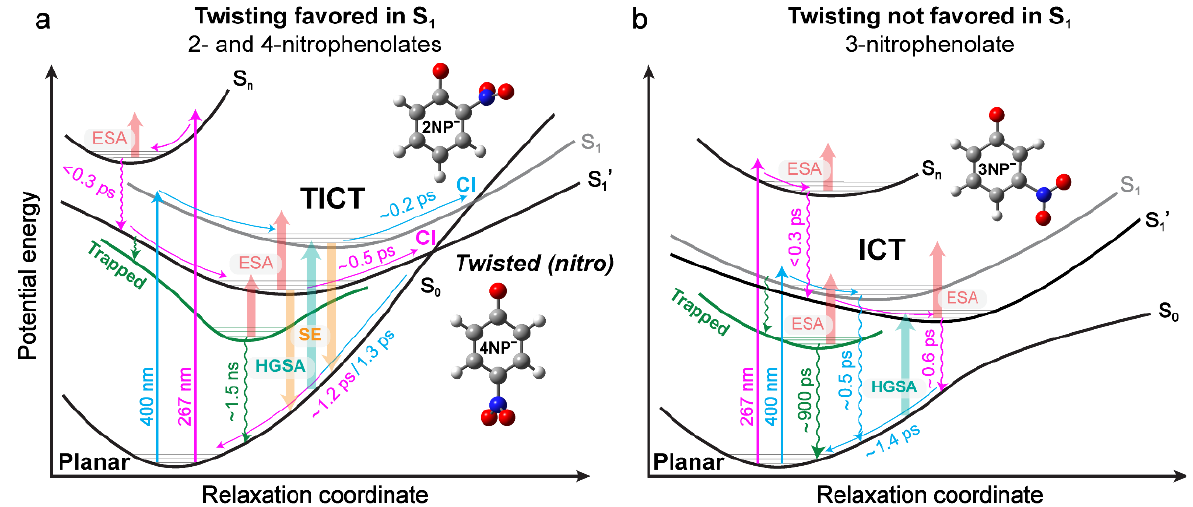
Figure 5. Schematics of the excited-state relaxation mechanisms of nitrophenolates in water. For ( a ) 2NP − and 4NP − , nitro-group twisting enables a TICT state that leads to a sloped S 1 /S 0 CI, whereas for ( b ) 3NP − , it does not twist much, and hence, accesses only an intramolecular charge transfer (ICT) state with no CI. Time constants for the pertinent processes are generally retrieved from global analysis of fs-TA spectra. The energy and relaxation coordinates are not scaled, while the colors for various processes roughly correspond to their associated wavelengths. The S 1 state is reached via 400 nm excitation, which is different from the S 1 ′ state reached via 267 nm excitation after the initial relaxation from S n . Representative ESA, SE, and HGSA features visible in the fs-TA data are indi- cated by “broad” maroon, orange, and green arrows, respectively.